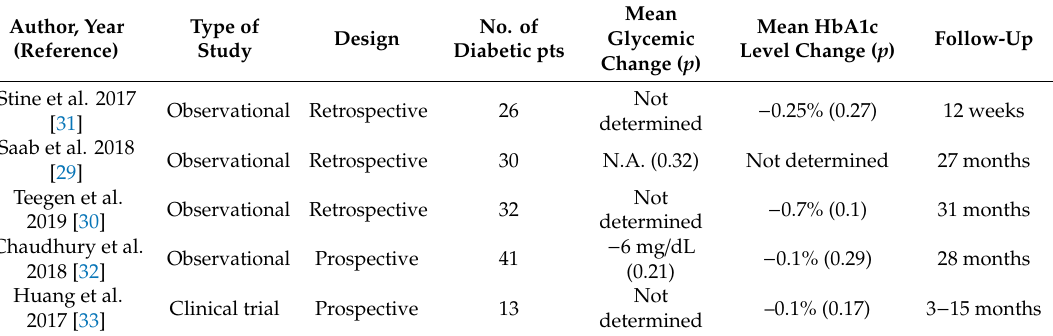
Table 4. Studies reporting no significant glycometabolic improvement in DAA-treated HCV-positive patients with